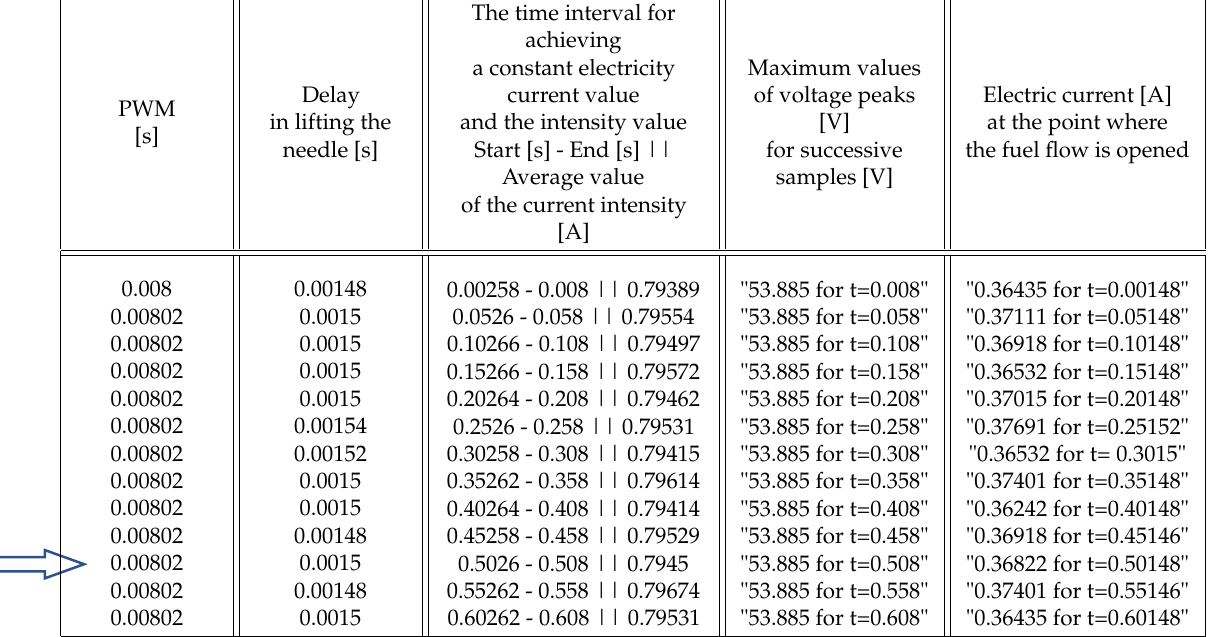
Table 3. User panel filled with selected values—exp. II—4 ms, 0.4